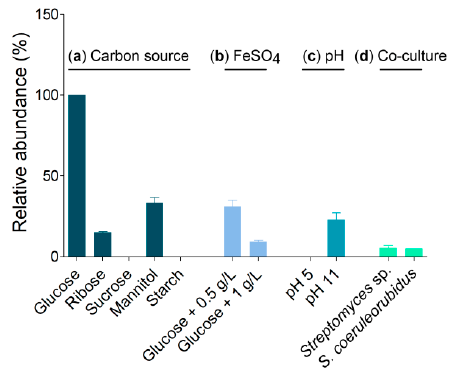
Figure 3. Relative nigericin production by the Streptomyces youssoufiensis SF10 strain cultured in Bennett’s agar medium using SSF for 14 days at 30 °C: ( a ) different carbon sources at pH 7; ( b ) D-glucose supplemented by iron (II) sulfate at pH 7 at the indicated concentration values; ( c ) D-glucose at different pH values; ( d ) D-glucose at pH 7, co-culture with Streptomyces sp. and S. coeruleorubidus.